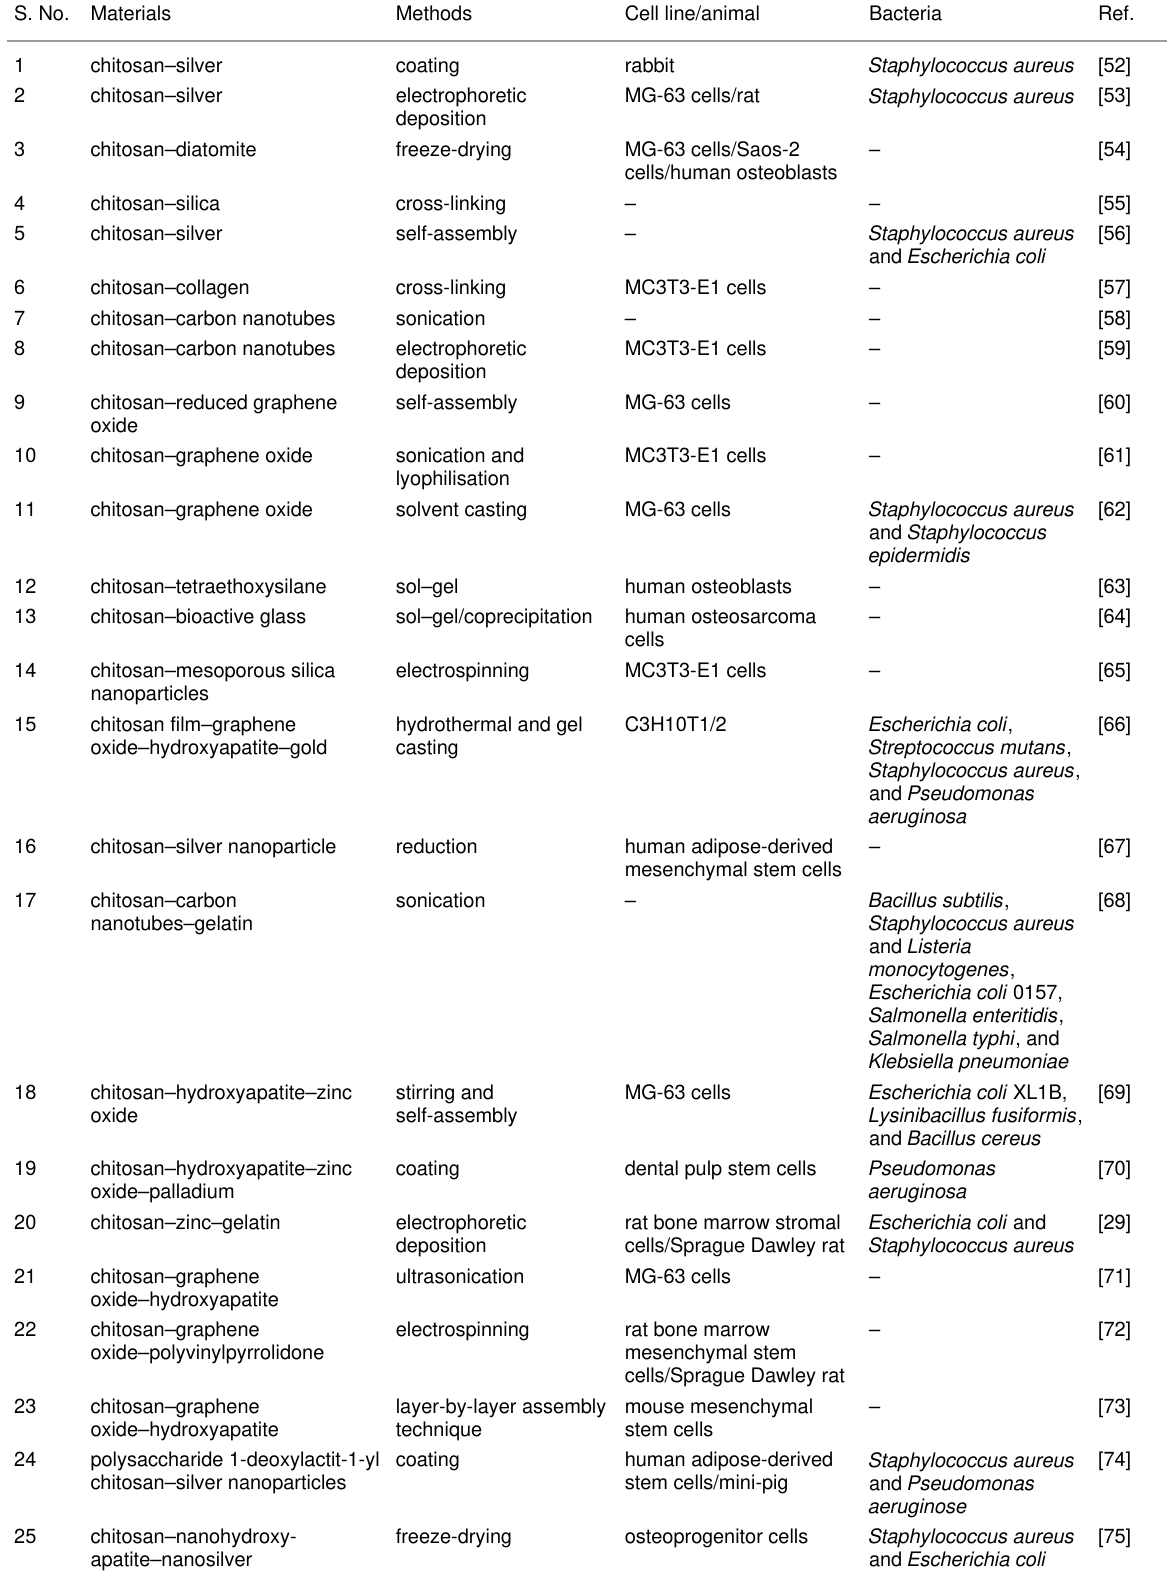
Table 1: Combinations of chitosan with several polymeric materials and nanoparticles to mimic the natural bone function. S. No.